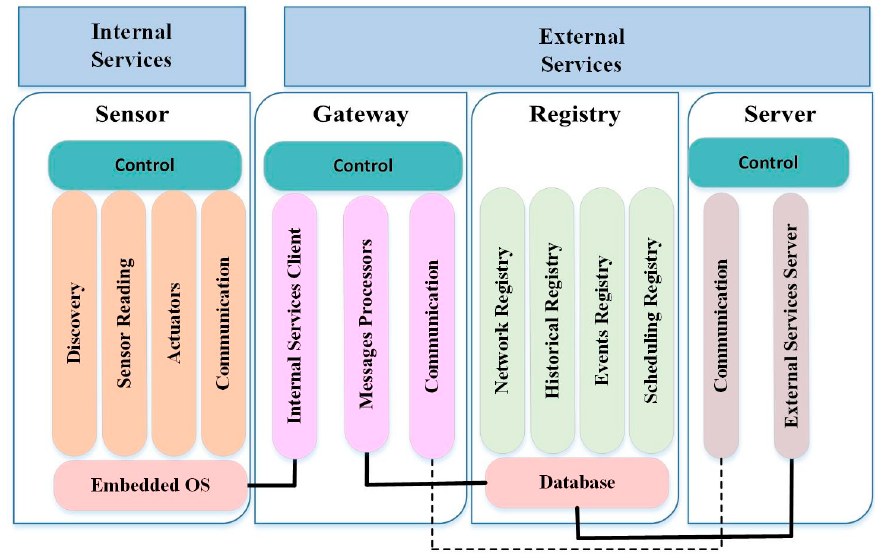
Figure 8. TinySOA Approach [53].